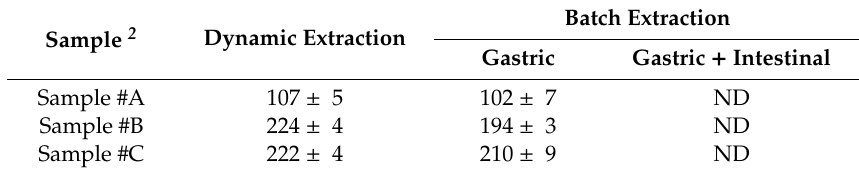
Table 1. Values of bioaccessible Zn 1 using the flow-based dynamic extraction and the static batch extraction.